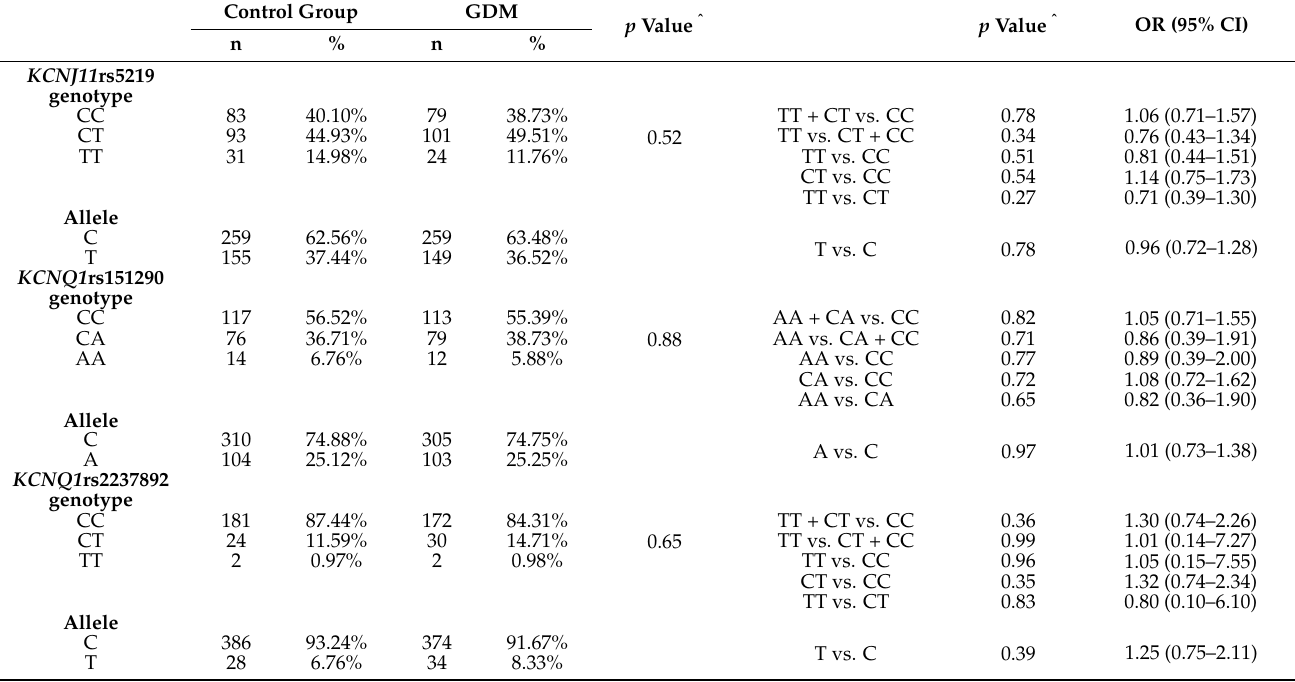
Table 1. Distribution of KCNJ11 and KCNQ1 genotypes in GDM women and control group.